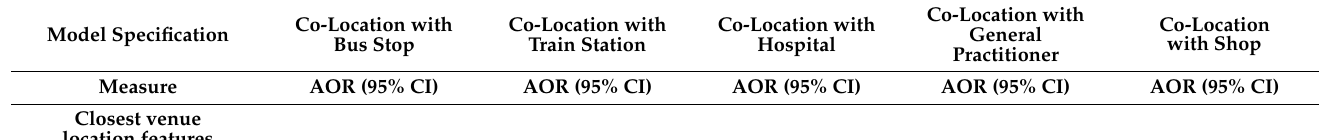
Table 3. Associations between closest venue (mobile and fixed) location built environmental features and women’s use of their closest breast screening